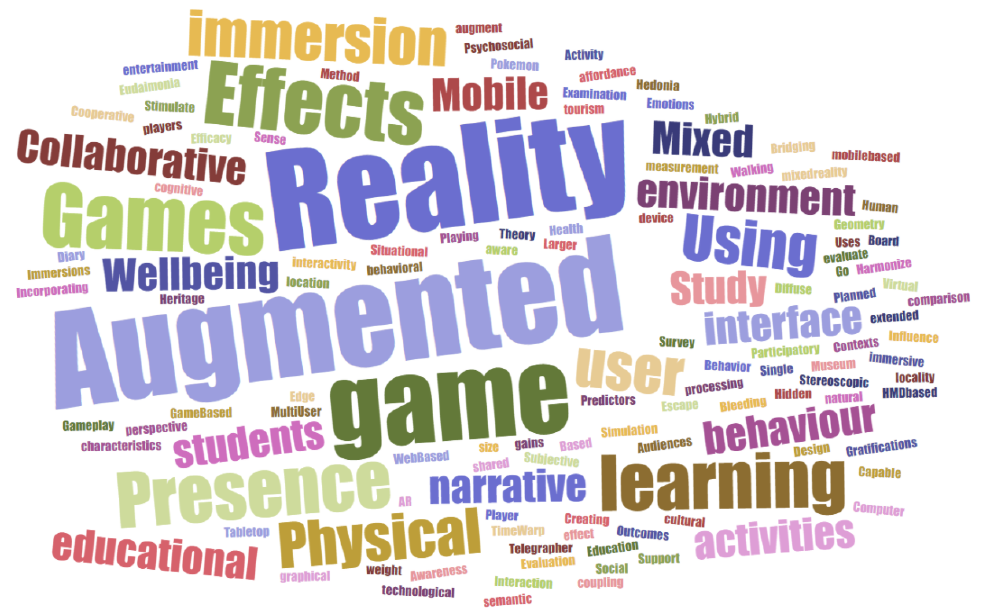
Figure 2. Word cloud generated from the titles of the 20 records analysed for the current study with the aid of the online word cloud generator Jason